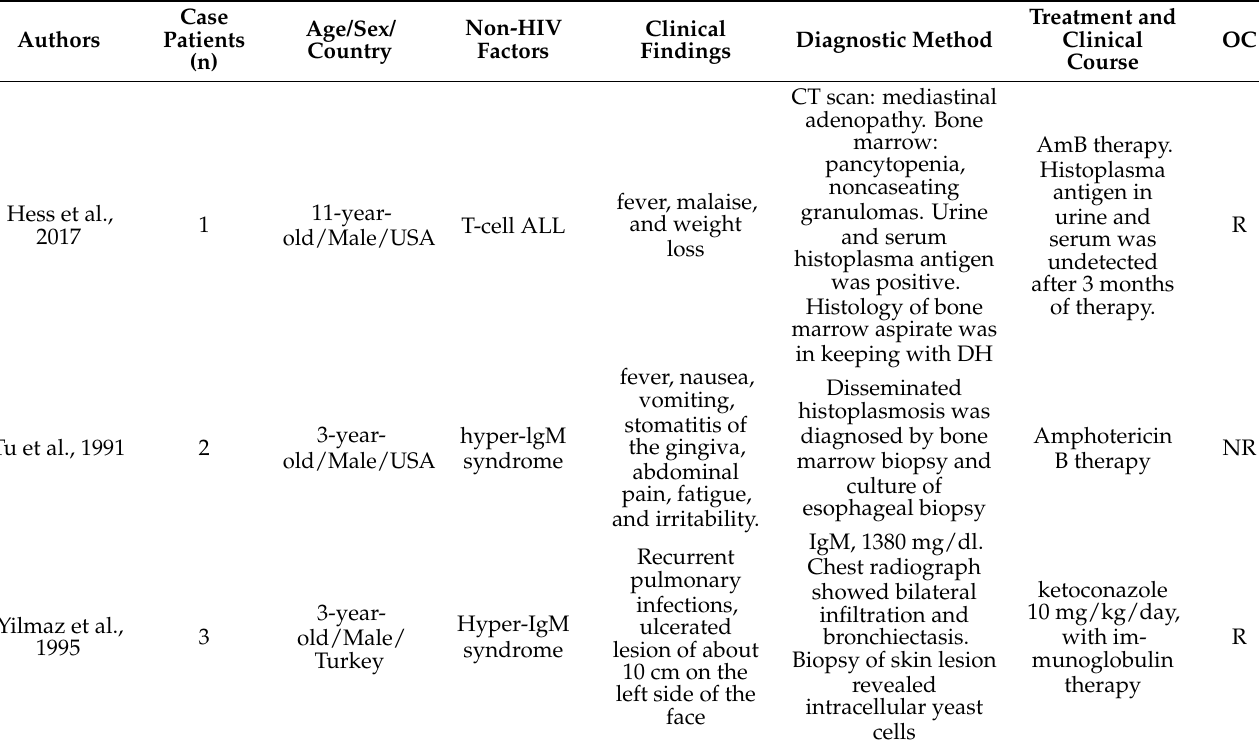
Table 3. Some case reports on pediatric histoplasmosis associated with non-HIV